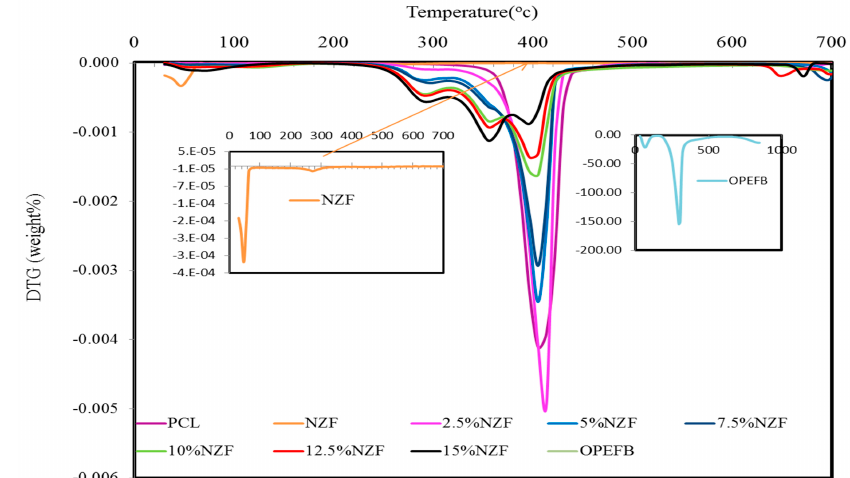
Figure 4. DTG thermograms of OPEFB fibres, NZF, PCL and NZF + OPEFB + PCL for different percentages of NZF filler in the composites.